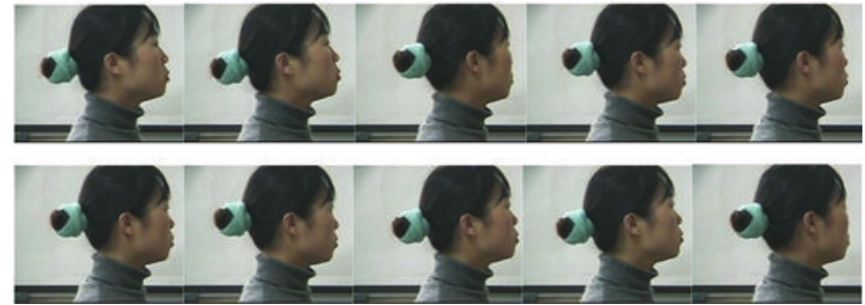
Figure 5: A typical subject from USTB database III under pose variations.